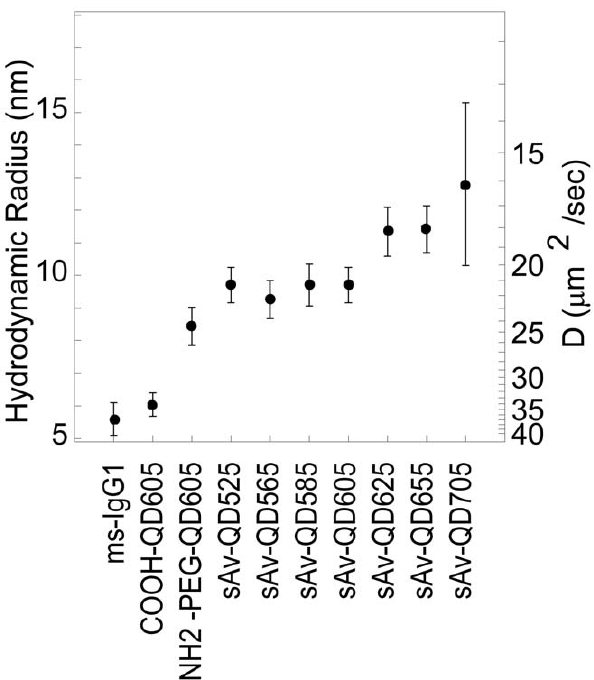
Figure 5. The diffusion coefficient, D, of commercially available QDs in aqueous buffer was measured with FCS. The hydrody- namic radius, R H , was estimated from the Stokes Einstein relation with T=293 K and g =1.04 cP. The calculated R H are given in Table